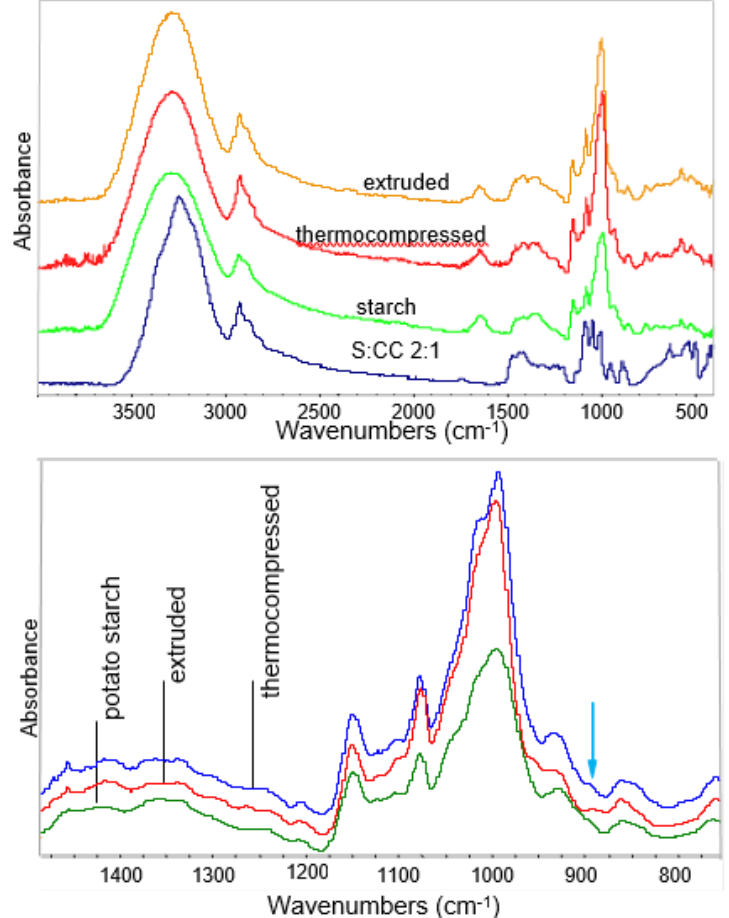
Figure 6. FTIR spectra for native PS, DES S:CC 2:1 and two TPS/S:CC 2:1 films obtained using different processing methods (thermocompression and extrusion followed by thermocompression).